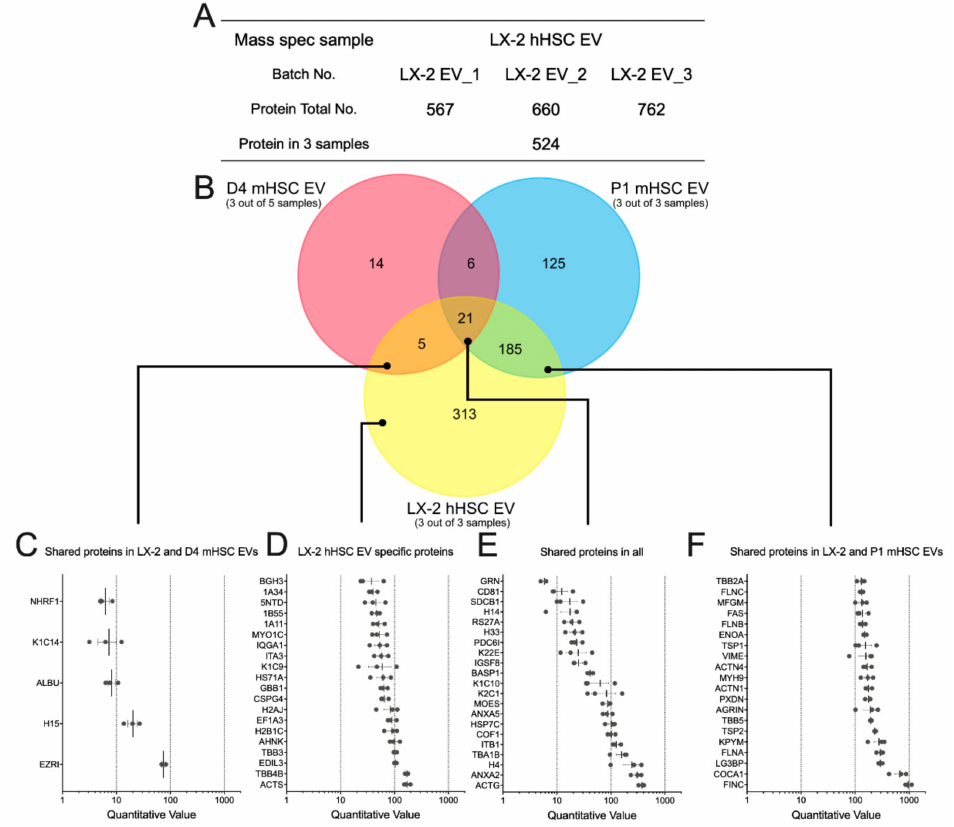
Figure 7. Proteomic composition of EVs from LX-2 hHSC and / or D4 or P1 mHSC. ( A ) Summary of quantitative features of EV proteins analyzed from LX-2 hHSC EV samples. ( B ) Venn diagram showing distribution of proteins between EVs from LX-2 hHSC, D4 mHSC and P1 mHSC. Also shown are the identities and quantifications of ( C ) the five proteins shared between LX-2 hHSC EVs and D4 mHSC EVs; ( D ) the 20 most abundant proteins specific to EVs from LX-2 hHSC; ( E ) the 21 proteins shared by EVs from all three cell types; and ( F ) the 20 most abundant proteins shared by EVs from LX-2 hHSC and P1